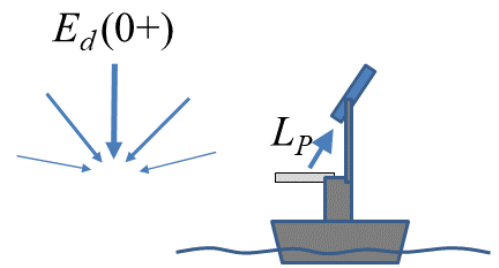
Figure 6. Schematic showing indirect measurement of 𝐸 𝑑0+ using a downward-pointing radiance sensor and a reflective plaque (sensor, plaque, and holder not to scale).